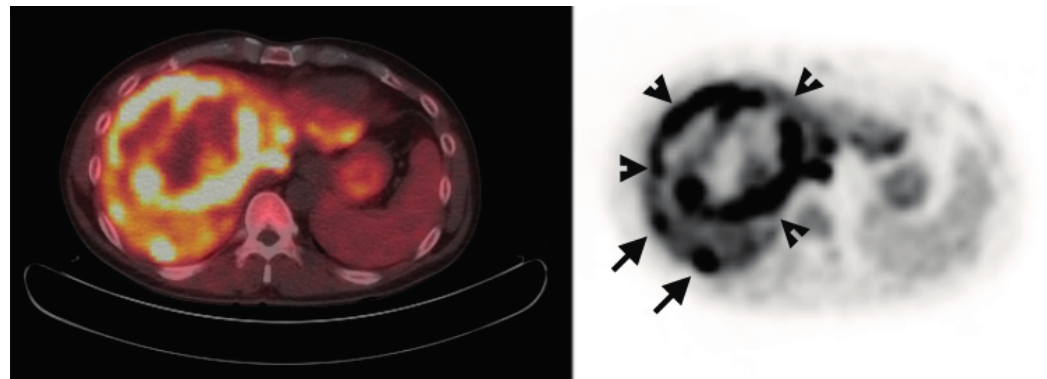
Figure 4. Metabolic heterogeneity in HCC. Corresponding PET/CT ( left ) and PET ( right ) shows a heterogeneous region of increased uptake within the liver in this patient with newly diagnosed liver mass. Two small satellite tumors ( arrows ) are adjacent to the dominant mass ( arrowheads surround ). Histologically, this was a poorly differentiated HCC tumor.